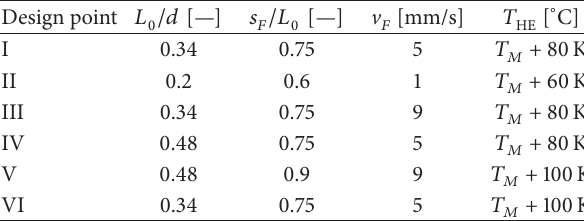
Table 4: Selected design points in hot plate